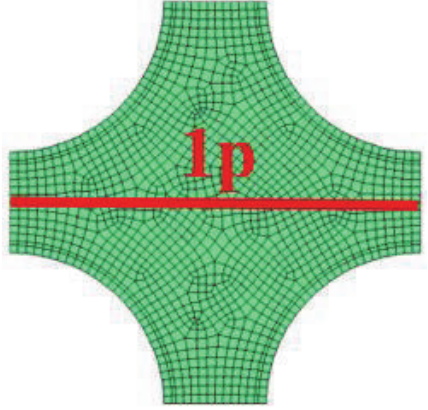
Figure 27: Pathline for the comparison of lateral flow.